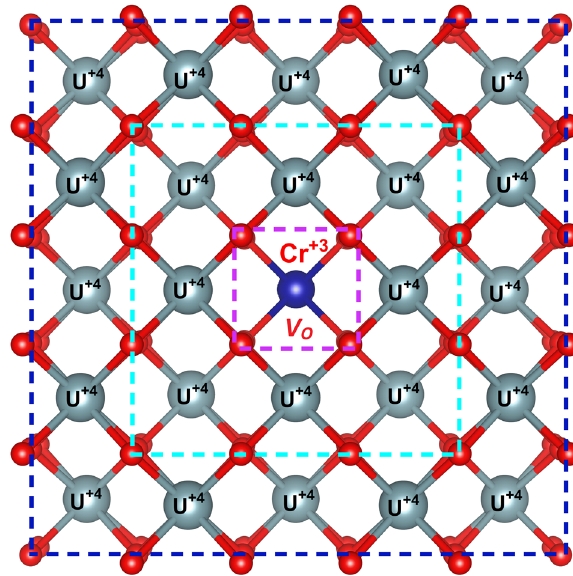
Fig. 4 | Determined structural model for Cr lattice matrix incorporation in Cr-doped UO 2 . Structural representation of the box-shell incorporation model of the incorporation of Cr into the UO 2 lattice matrix forming (Cr +3 x U +4 1 − x )O 2 − 0.5 x as derived from the EPR, HERFD-XANES and EXAFS analysis of this investigation. The 1st box-shell (purple) highlights the Cr +3 cation incorporation which involves the formationofanoxygenvacancydefect, V O ,forchargecompensation.The2ndbox- shell (cyan) indicates the locally distorted U lattice region derived from EXAFS analysiswhichshowedshorterCr – Udistancesresemblinganenvironmentcloserto UO 3 orCrUO 4 thanthatofU – UinpristineUO 2 .The3rdbox-shell(darkblue)which resemblescloselythatoftheU +4 O 2 lattice,i.e.,farenoughawayfromtheCr +3 cation to not receive signi fi cant lattice distortions. Furthermore, the uranium cationic lattice stays consistently as U +4